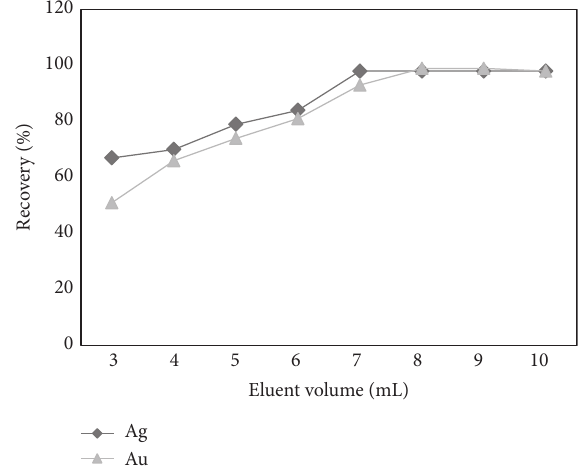
F 4: Effect of pH of sample solution on percent recovery of Ag(I) and Au(III) by TREN-Fe